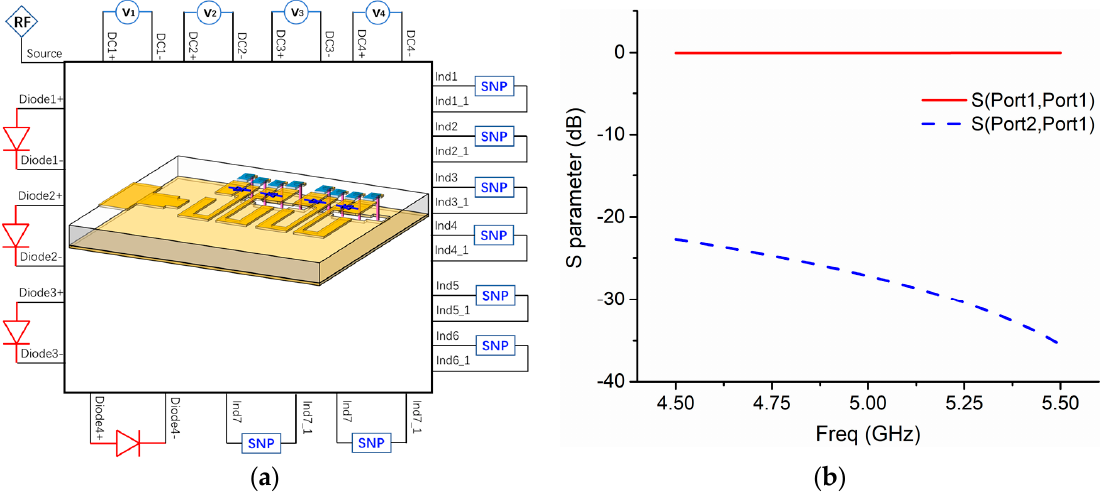
Figure 5. ( a ) EM co-simulation model including passive EM model, active element PIN diodes, and inductance chip; ( b ) simulated S-parameters from the SNP file of inductor (Murata LQW18AN22NG00) .